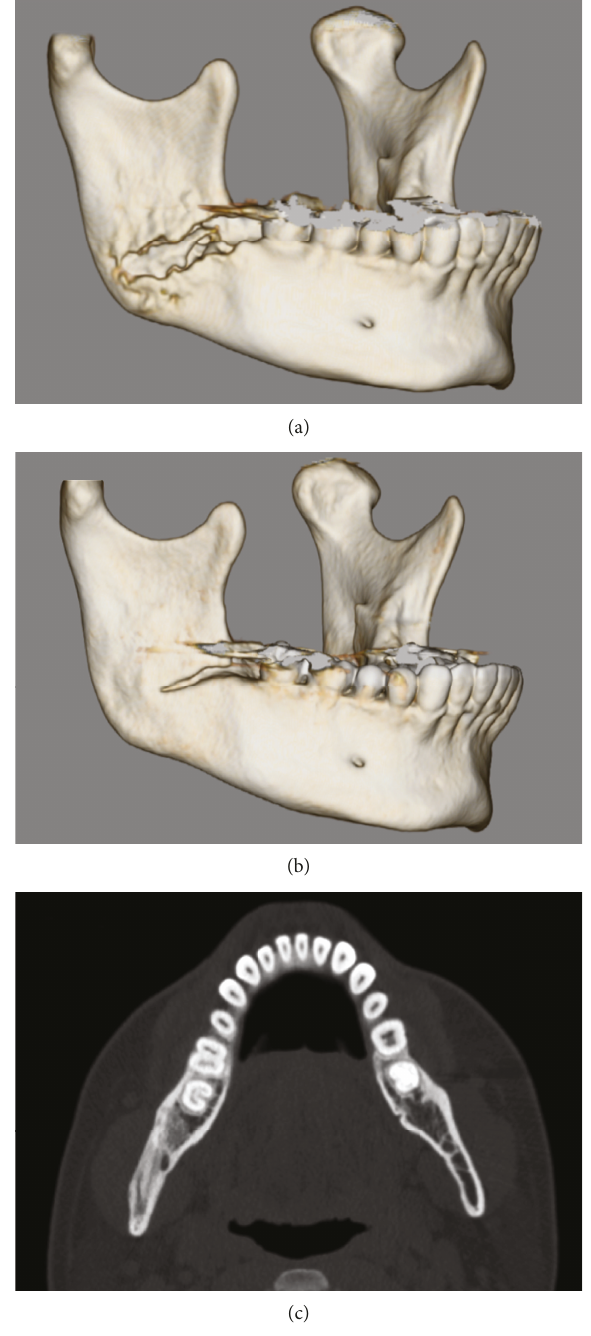
Figure 8: Three-dimensional computed tomographic (3D CT) scan obtained during the initial visit (a). 3D CT (b) and coronal CT (c) scans obtained 6 months after sequestrectomy and curettage. Although the CT obtained at the initial visit shows destruction of buccal cortical bone from the socket to the right mandibular angle and formation of bone sequestrum (a), CT obtained at 6 months shows bone healing at the lesion site, except for the remaining slight slit of the buccal cortical bone (b,